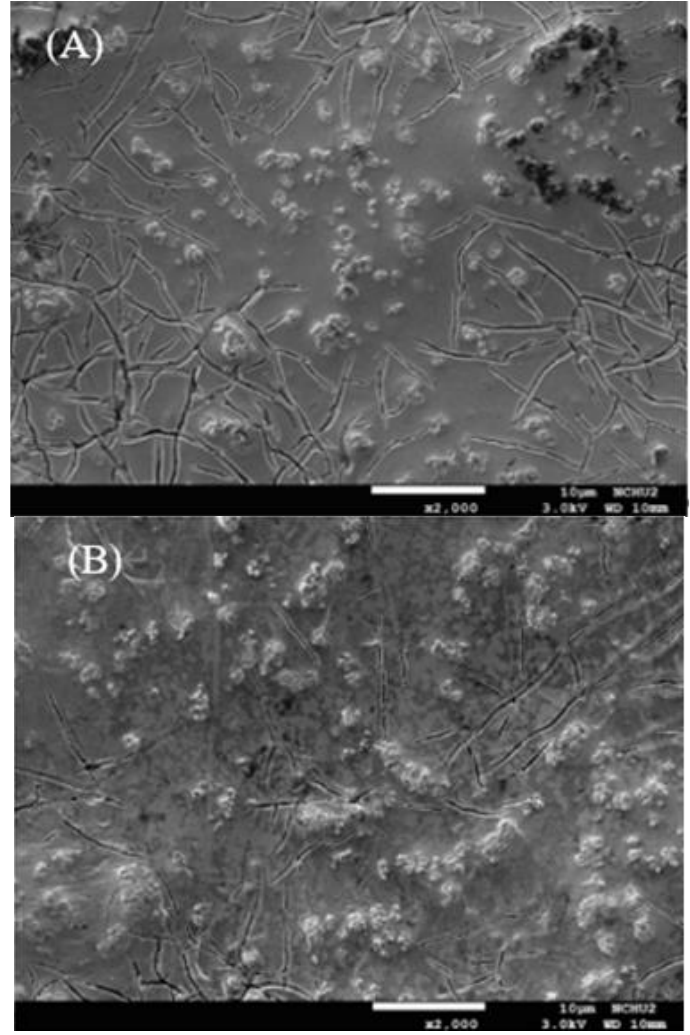
Figure 7. The micrograph of IrO 2 -Ta 2 O 5 /Ti electrode ( a ) before operation; ( b ) after 100 h operation. Table 2. The percentage of elements before and after electrode